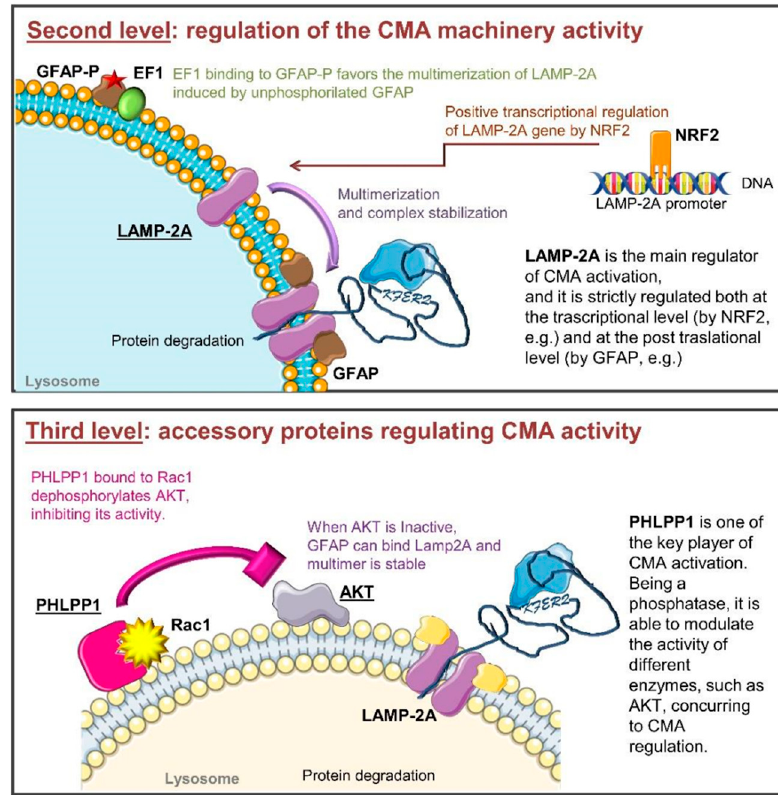
Figure 1. Schematic representation of the multi-level CMA (chaperone-mediated autophagy) regu- lation machinery. Panel 1: The first regulatory level is based on the availability and accessibility of the KFERQ motif. Non-canonical motifs can be modified to be recognized by chaperone proteins. HSC70 chaperone delivers specific proteins to the lysosome. Panel 2: The second regulatory level depends on LAMP-2A quaternary structure. Its trafficking in the lysosomal membrane is finely reg- ulated. Moreover, unphosphorylated GFAP (GFAP) stabilizes the LAMP-2A multimer, favoring the translocation of unfolded proteins within the lysosomes. When GFAP is present in its phosphory- lated form (GFAP-P), it interacts with EF-1 α , determining the disassembling of LAMP-2A multi- mers. In addition, LAMP-2A de novo expression can be regulated by the transcription factor NRF-2. Panel 3: The third regulatory level is due to the availability of accessory proteins among which the main regulator is PHLPP1. It is a phosphatase influencing the activity of other proteins. Rac-1 bound to PHLPP1 favors its activity on AKT. Inactive AKT is not able to phosphorylate GFAP allowing LAMP-2A multimer stabilization.